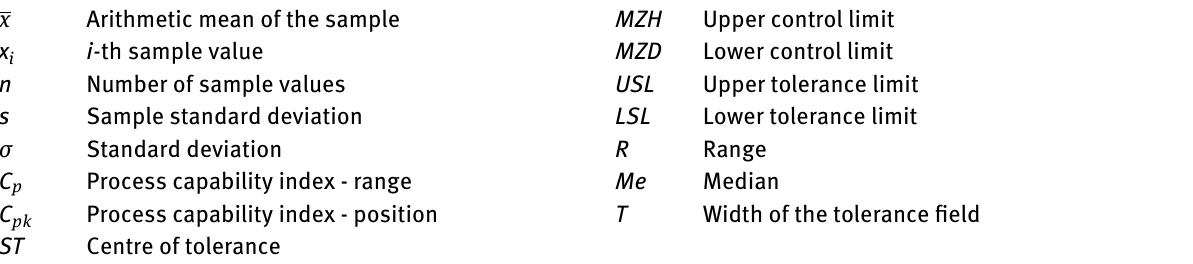
Table 1: The overview of used quantities [Source: The authors]